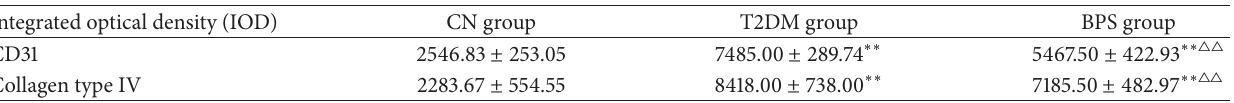
Table 7: p38 MAPK mRNA in the kidney tissues of rats in experiment using RT-PCR ( 𝑛 = 6 , 𝑋 ± 𝑆 ). Group 𝑁 Expression of p38 MAPK mRNA (%) CN group 6 0.1599 ± 0.0663 2.4334 ± 1.3923 △△ ∗ 𝑃 < 0.05 and ∗∗ 𝑃 < 0.01 T2DM group and BPS group compared with CN group rats and △ 𝑃 < 0.05 and △△ 𝑃 < 0.01 BPS group compared with the T2DM